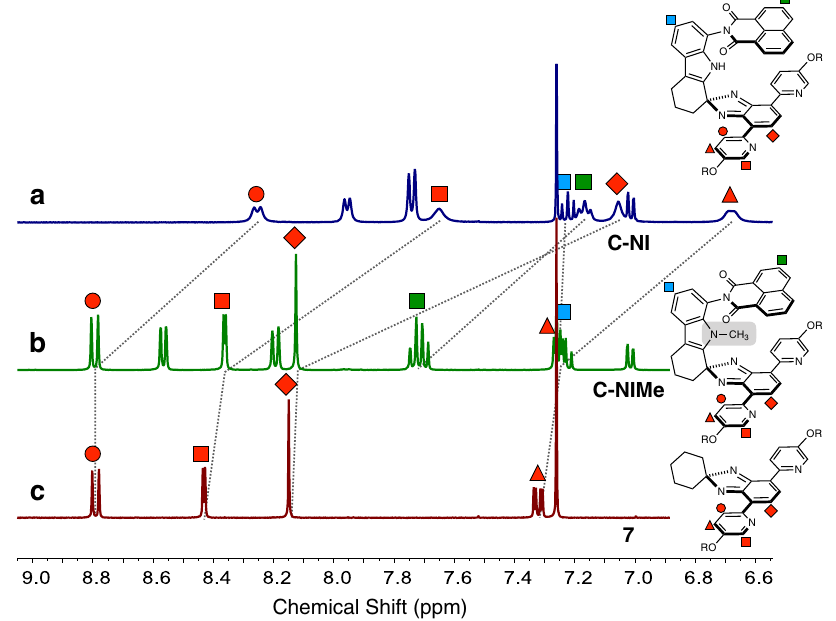
Fig. 3 Spectroscopic signatures of intermolecular association. Partial 1 H NMR (400 MHz) spectra of a C-NI (9.2 mM), b C-NIMe (13 mM), and c 7 (9.2 mM) in CDCl 3 at T = 298 K. NMR nuclear